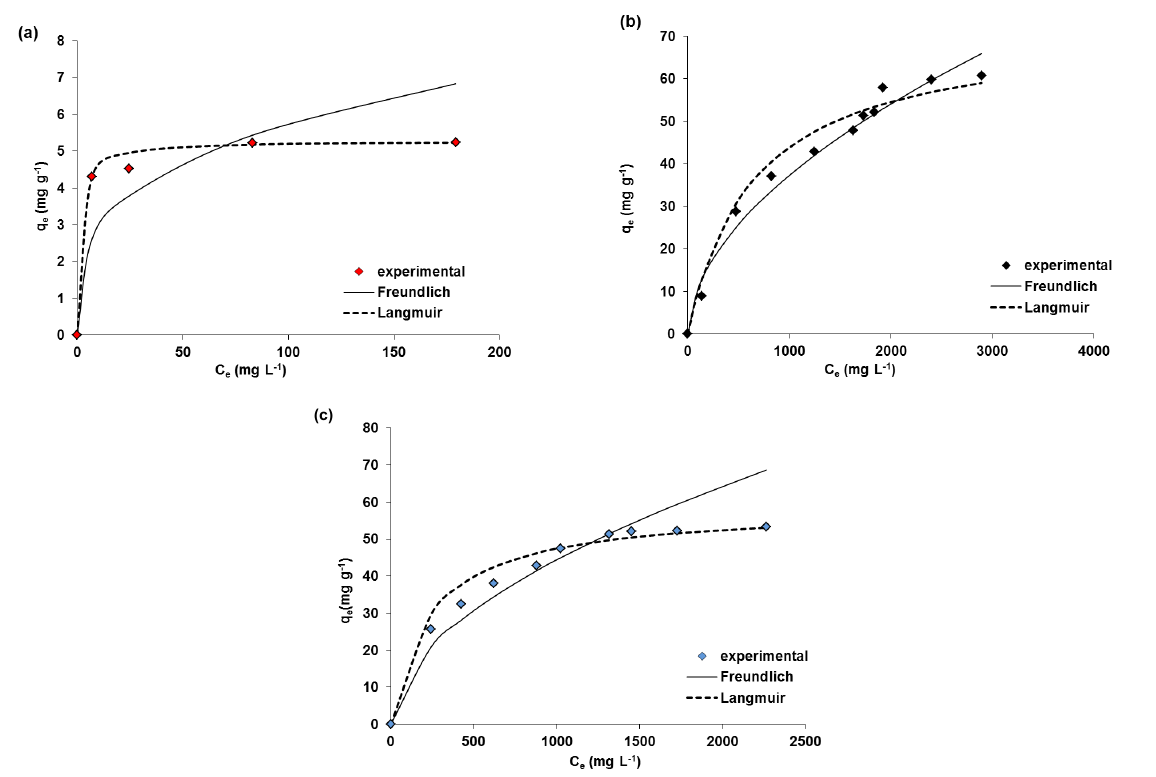
Figure 4: Equilibrium adsorption data of C.I. Acid Orange 7 (a), C.I. Reactive Black 5 (b) and C.I. Direct Blue 71 (c) on the aminosilane modified silica and the fitting of the Langmuir and Freundlich isotherm model to experimental data ( conditions: volume: 50 mL, sorbent mass: 0.5 g, agitation speed: 180 rpm, temperature: 25 o C, phase contact time: 60 min).